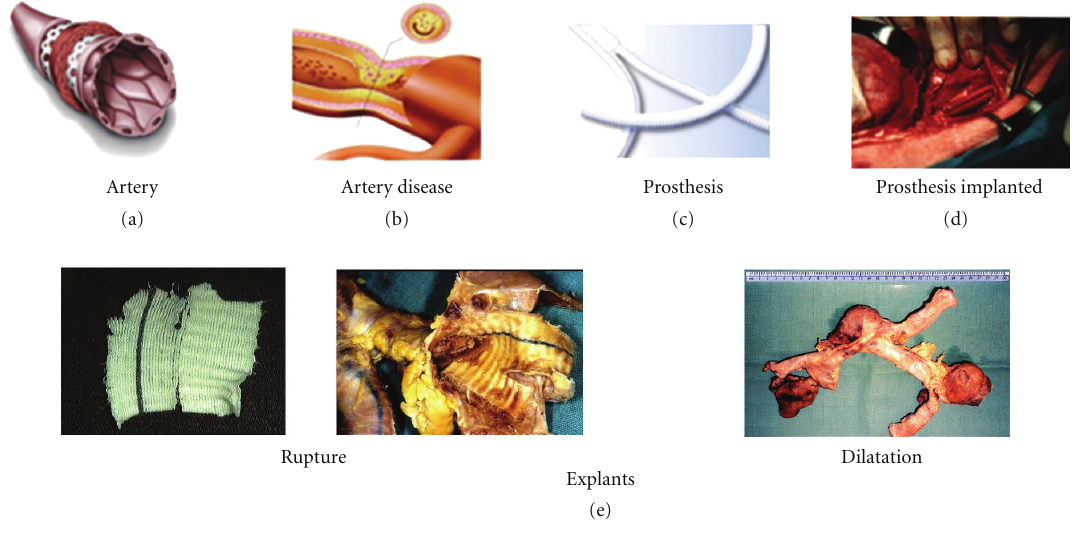
Figure 1: Dysfunctions of arteries and prostheses. Sources: (b) http://archimede.bibl.ulaval.ca/archimede/fichiers/22413/ch02.html. (c) P´erouse